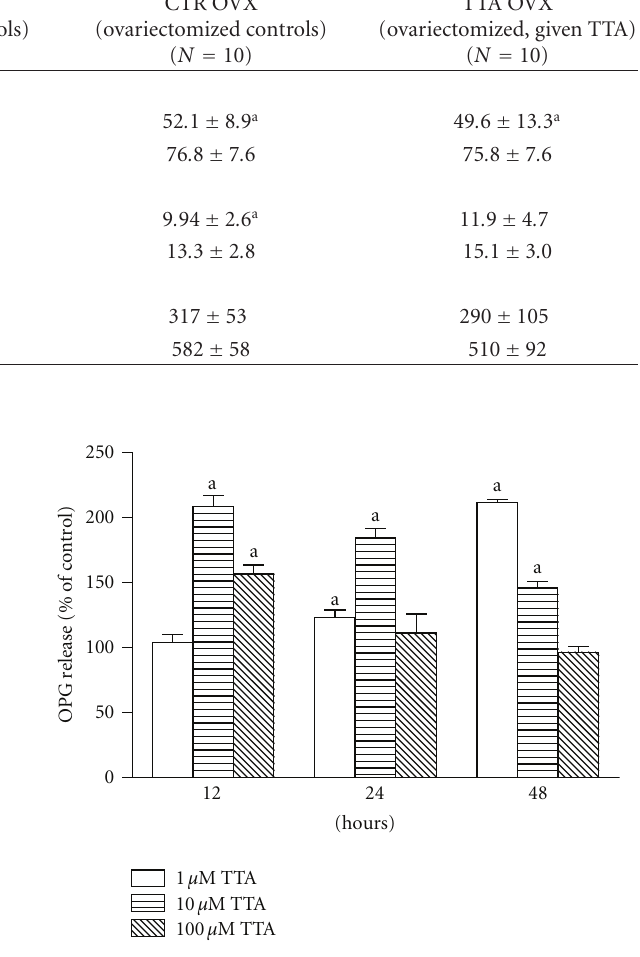
Figure 2: The e ff ect of TTA (1.0, 10 and 100 μ M) on osteo- protegerin (OPG) release to the cell medium from MC3T3-E1 preosteoblast cells after 12, 24, and 48 h of stimulation. Data are in mean ± SD and presented as OPG related to the amount of total protein and as % of control (untreated cells at same time point), a P < 0 . 05 when compared to